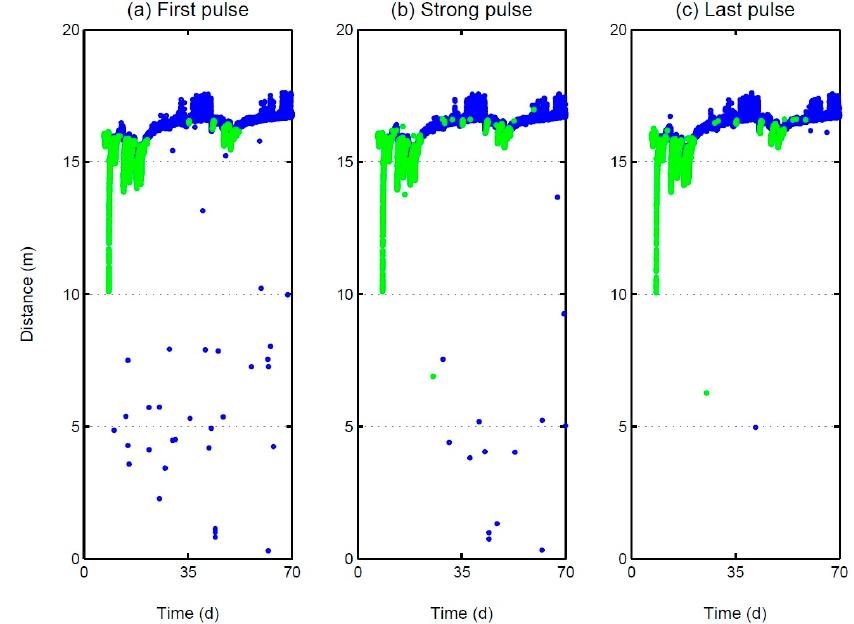
Figure 3. Raw distance data measured by the tested Lidar during the experiment in the Amacuzac River. Each row corresponds to a different Lidar configuration: ( a ) “first pulse”; ( b ) “strongest pulse”; and ( c ) “last pulse”. Blue symbols show data associated with moderate signal strength ( I = 3) and green symbols show data associated with a high signal strength ( I = 4).